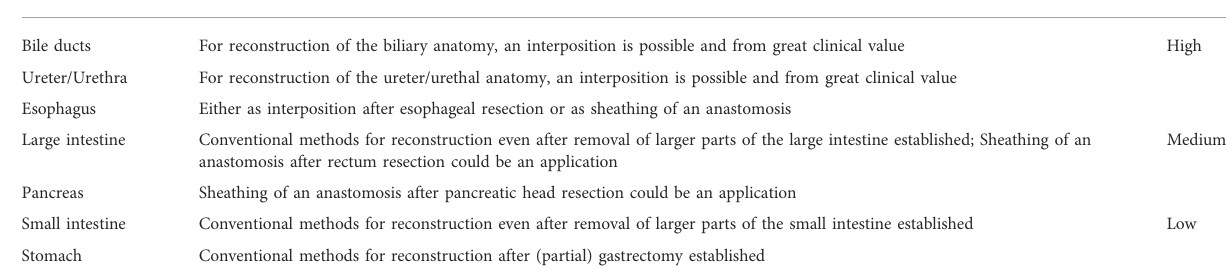
TABLE 1 A clinician ’ s perspective on potential applications of biocellulose in modern abdominal surgery.